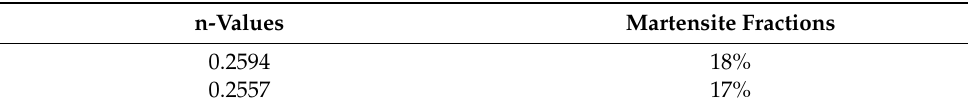
Figure 6. Comparison of strain hardening exponent (n) with corresponding martensite volume fraction, i.e., 18% and 17%. Table 4. n-values versus martensite fractions of DP steels.